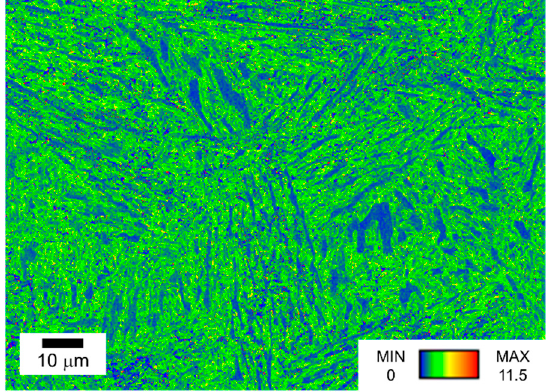
Figure 5. Kernel Average Misorientation of the N H Q L showing regions of recrystallized α -ferrite shown in blue.